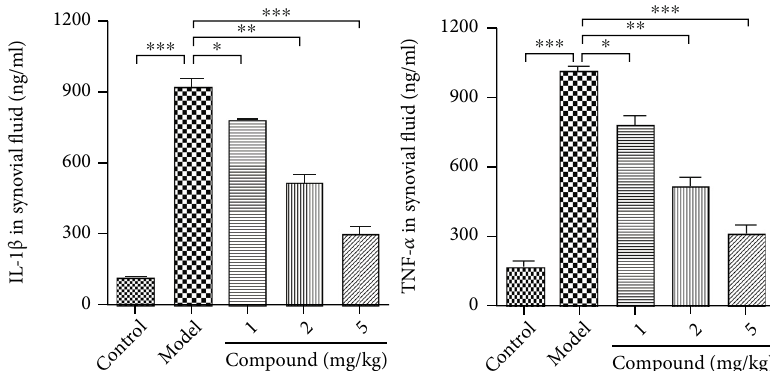
Figure 4: Signi fi cantly decreased content of in fl ammatory cytokines released into synovial fl uid later than compound treatment. The LPS was injected into the mice to induce the foot and ankle arthritis animal model, and then, complex was disposed at the concentration of 1, 2, and 5 mg/kg. ELISA assay was conducted, and degree of in fl ammatory cytokines released into synovial fl uid was